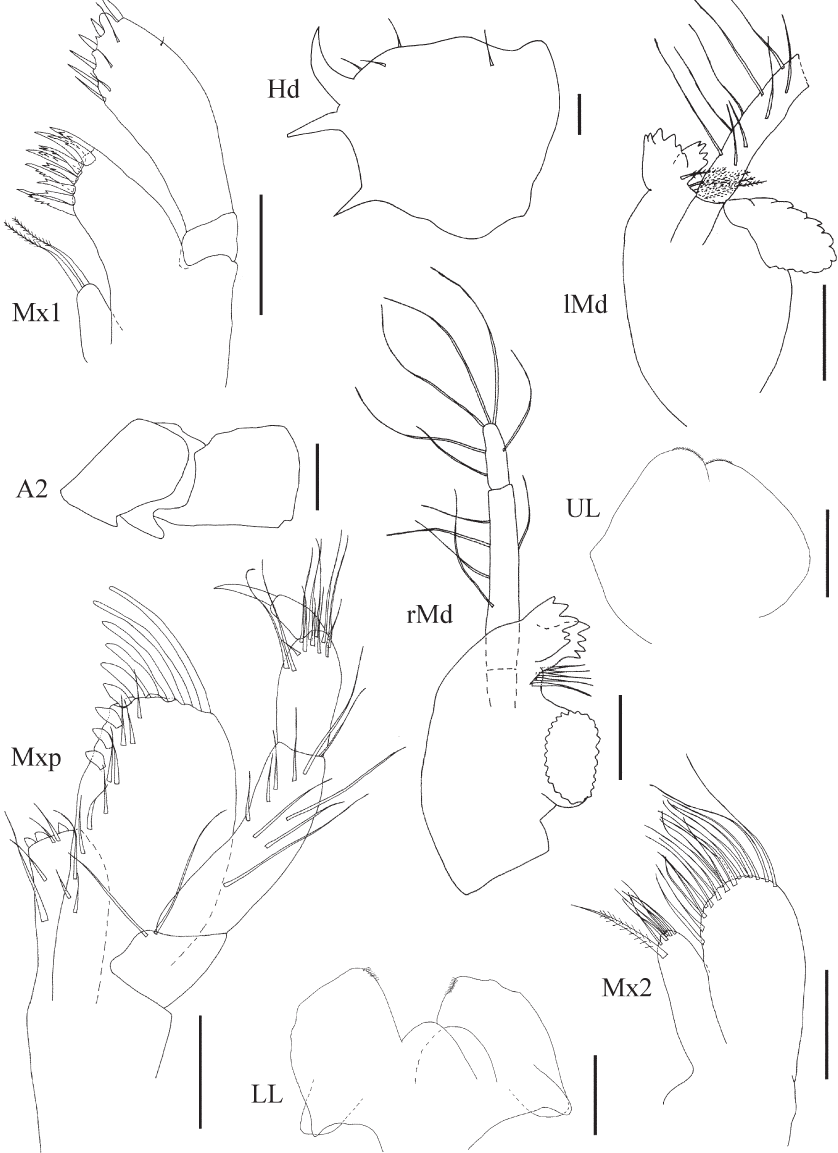
Fig . 2. – Lepechinella campensis n. sp., holotype, sex unknown, 5.7 mm, MnrJ17384, oceanprof i #45, 22°10’54.4”S to 39°52’19.4”w. Scale bars = 0.1